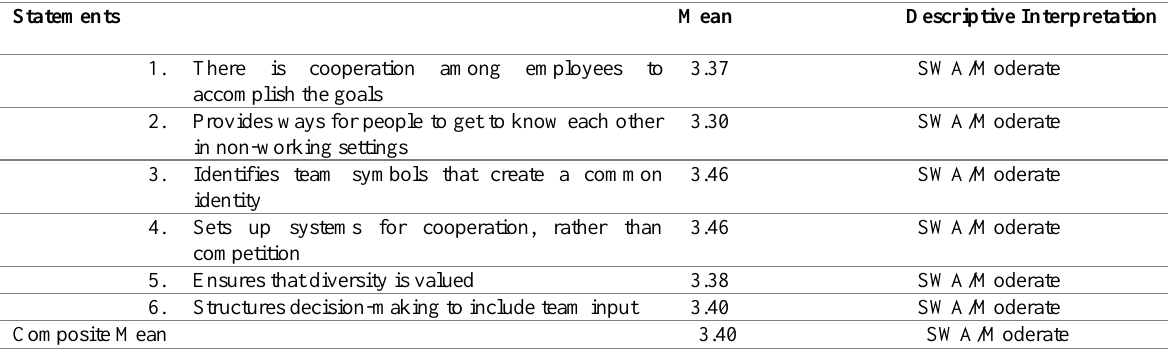
Table 6: Organizational Climate Along with Team Commitment